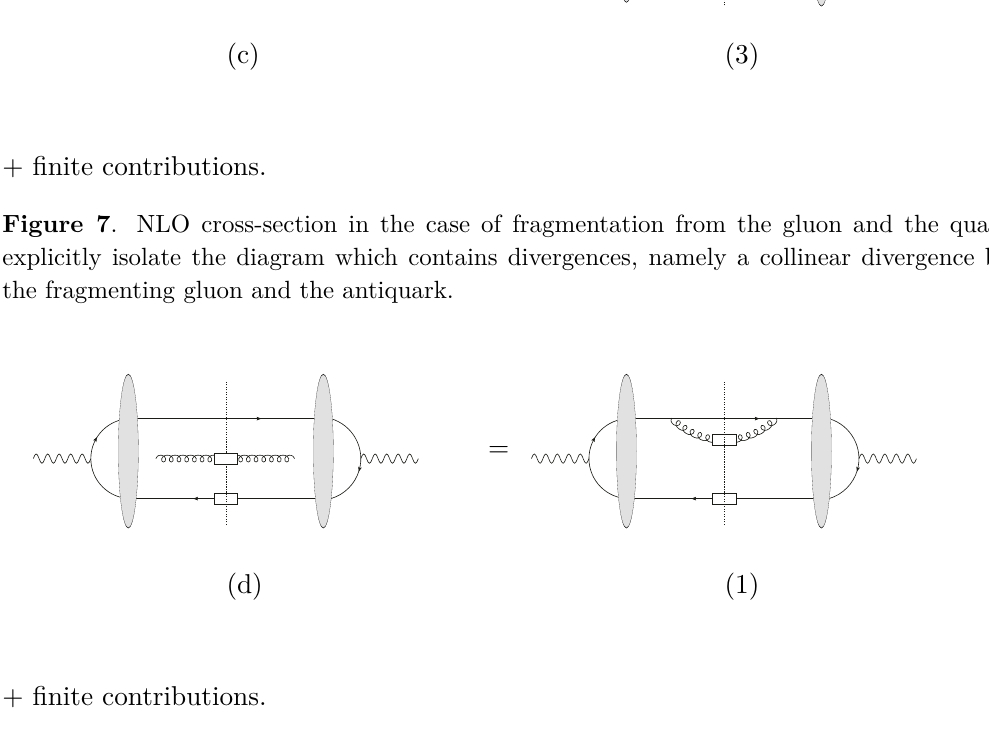
Figure 8 . NLO cross-section in the case of fragmentation from the gluon and the antiquark. We explicitly isolate the diagram which contains divergences, namely a collinear divergence between the fragmenting gluon and the